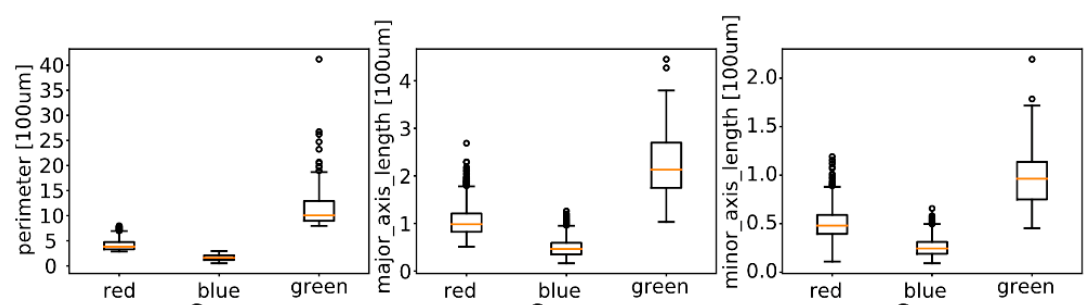
Figure 13. Distribution of most informative features across clusters: Perimeter, major axis, and minor axis. The boxes present median, first and third quartiles, and whiskers the furthest data point not further than from the quartile than 1.5 × IQR (interquartile range). Table 3. The sizes and proportions of clusters in the feature space.